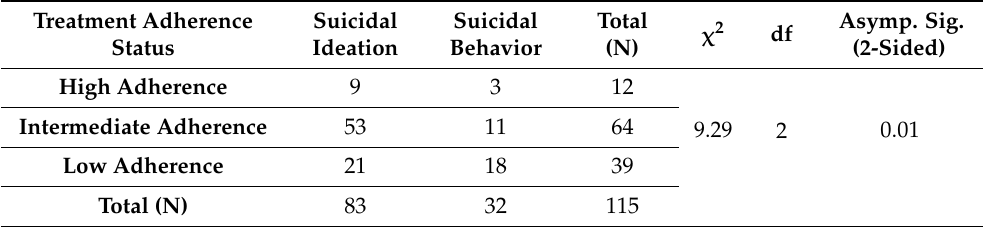
Table 5. Treatment adherence status shown by included subjects (N = 115) with suicidal ideations and